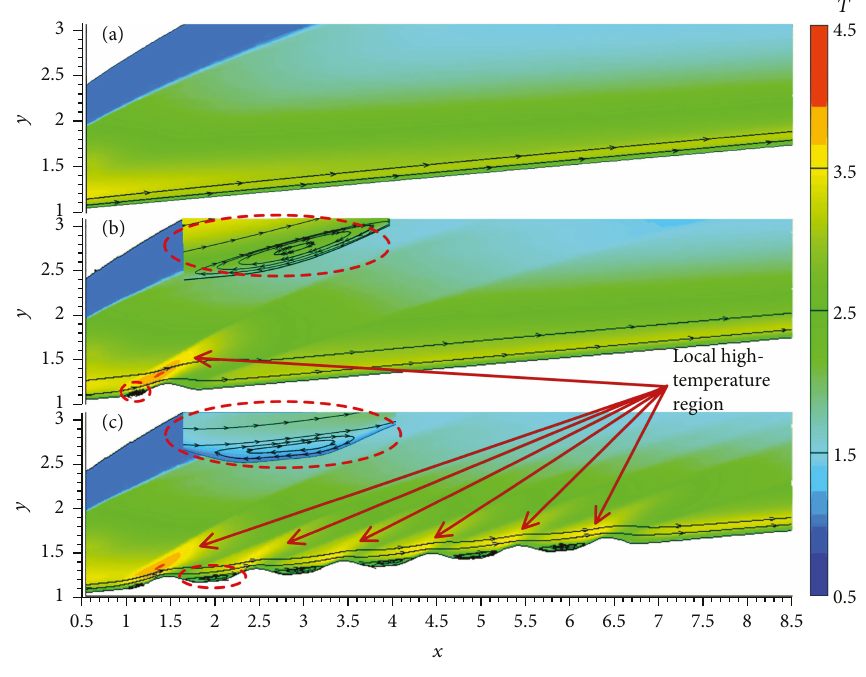
Figure 2: Pressure contour and streamline pattern of the undisturbed hypersonic fl ow fi eld.